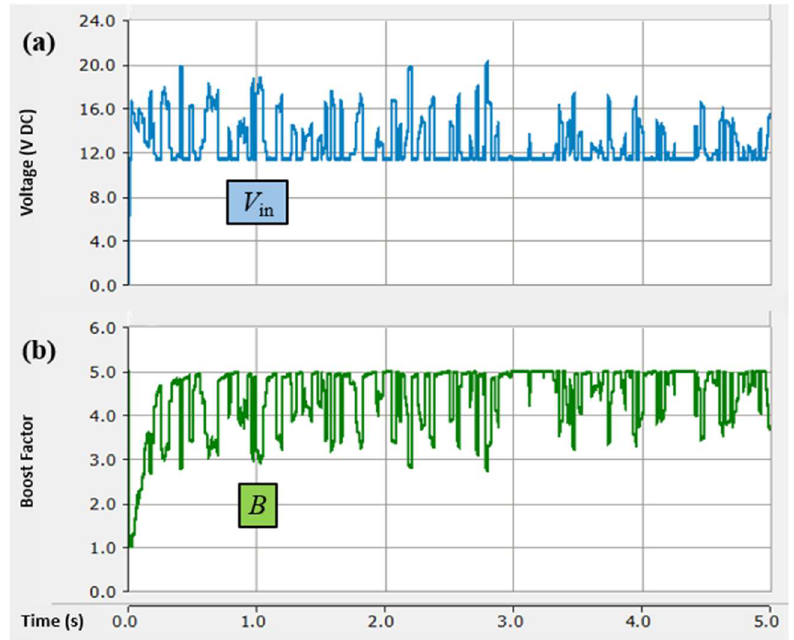
Figure 14. qZSI-based PVEH operation during uncertain output performances of the CB: ( a ) Fluctuation of input voltage. ( b ) Corresponding boost factor for voltage restoration at DC-link.